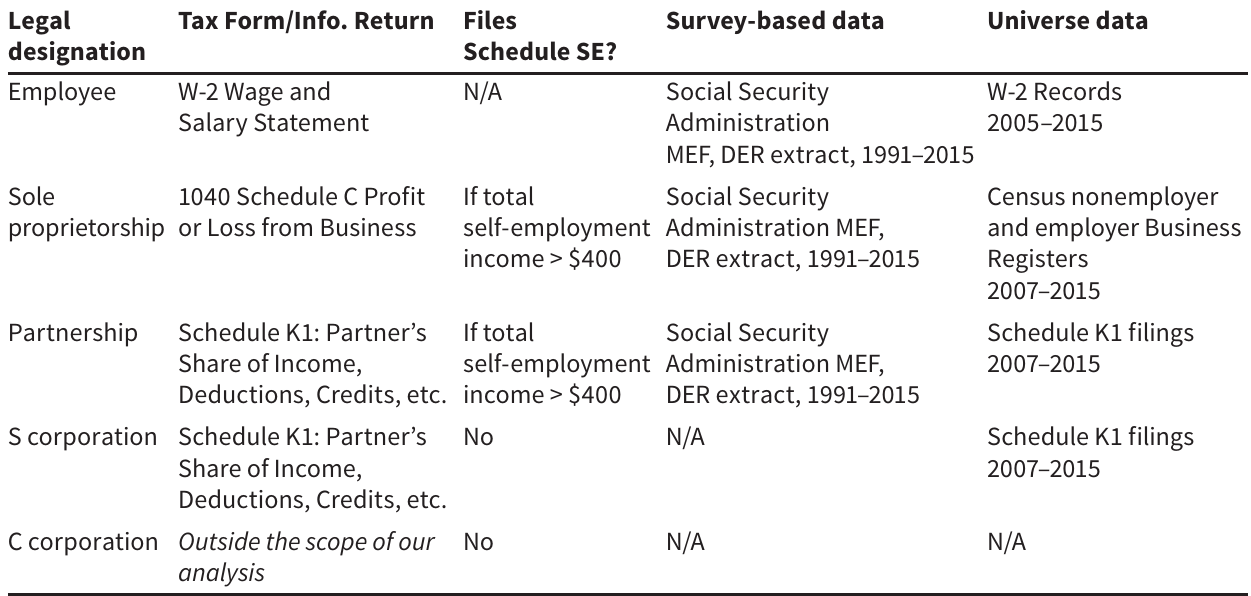
Administrative records data on U.S. wage and salary and